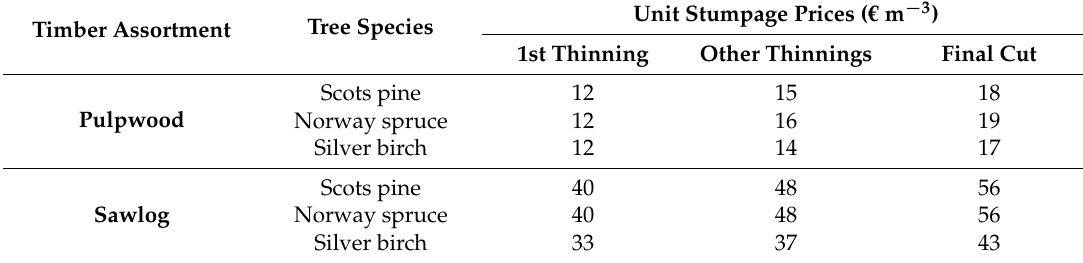
Table A1. Stumpage prices for different tree species (Scots pine, Norway spruce and birch), cutting types and timber assortments (2011–2016) over the whole of Finland. No sawlogs were harvested in the first